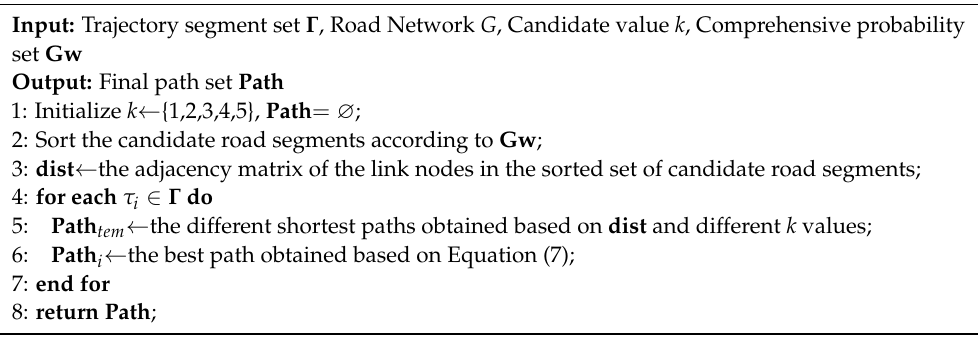
Algorithm 3: Best path selection